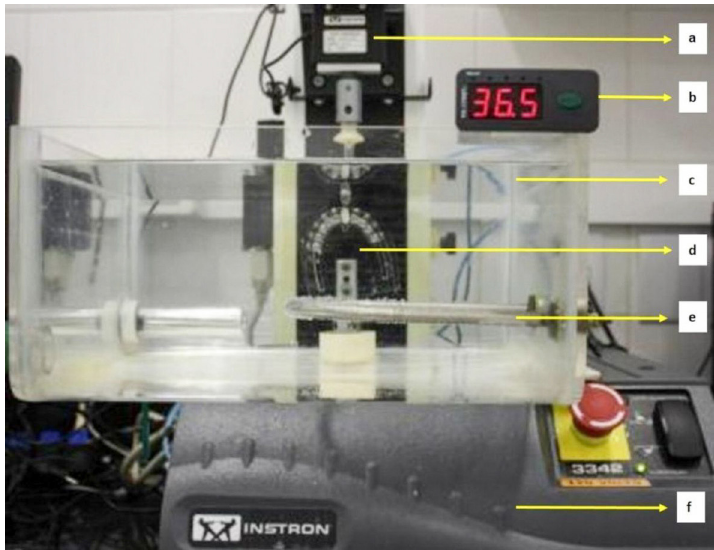
Figure 4- Clinical simulation device. (a- Load cell of 10N; b- Digital thermostat; c- Acrylic container; d- Acrylic resin plate; e- Submersible electric resistance; f- Universal Testing